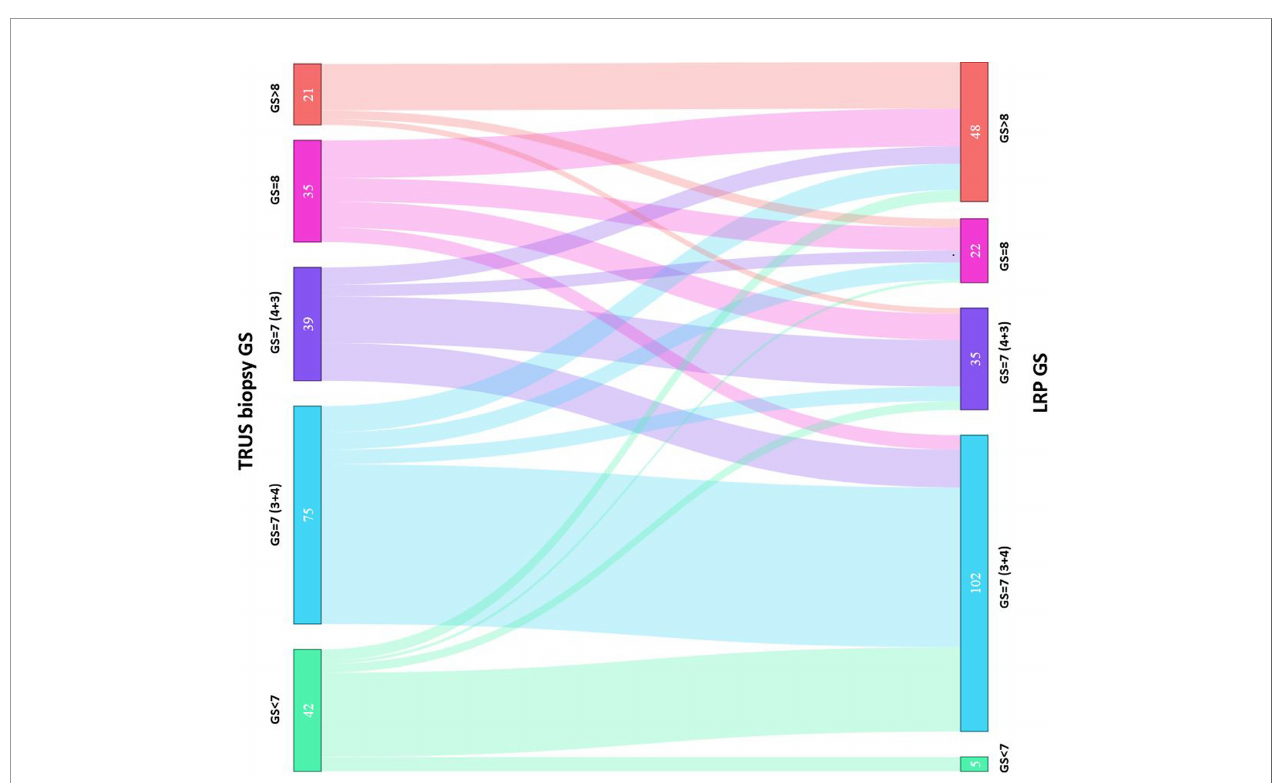
FIGURE 2 | Sankey diagram of comparison between biopsy Gleason Score and prostatectomy Gleason